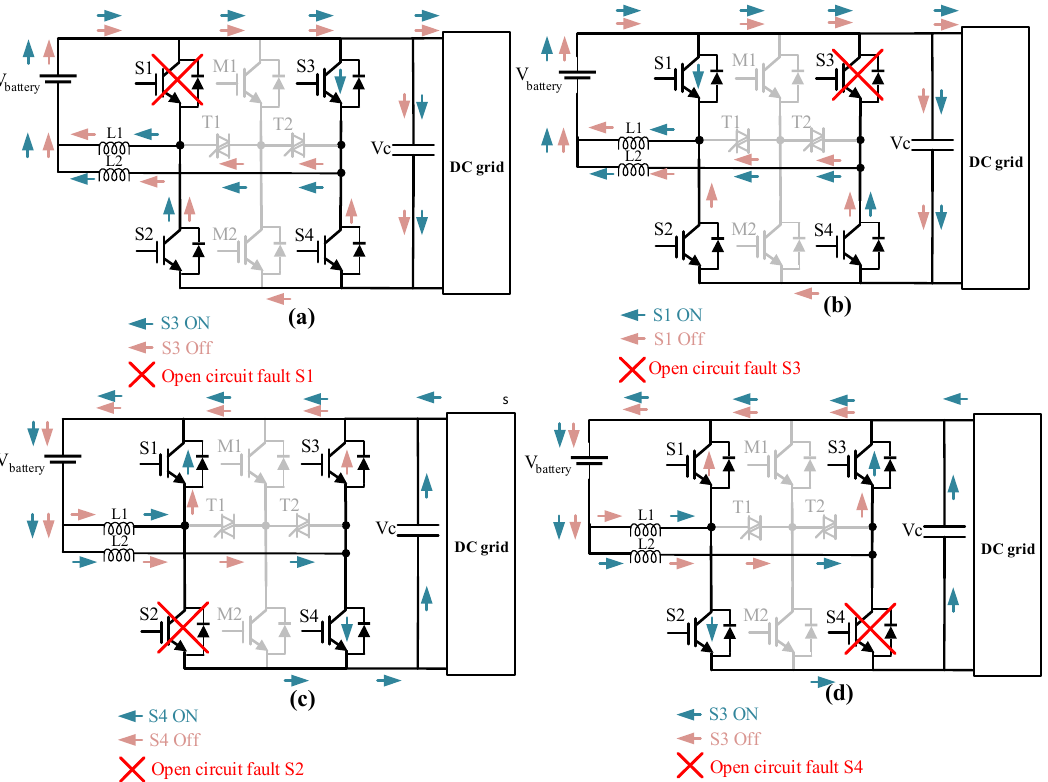
Figure 5. Operating modes under faulty state: ( a ) OCF in power switch S1; ( b ) OCF in power switch S3; ( c ) OCF in power switch S2; ( d ) OCF in power switch S4.